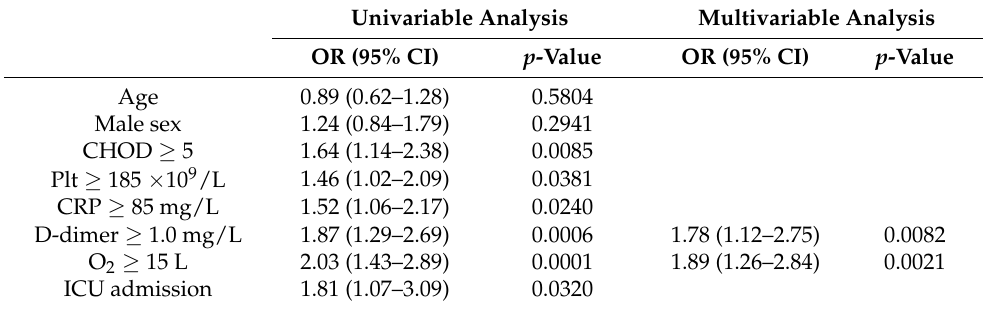
Table 3. Univariable and multivariable analysis of factors associated with pulmonary thrombosis.